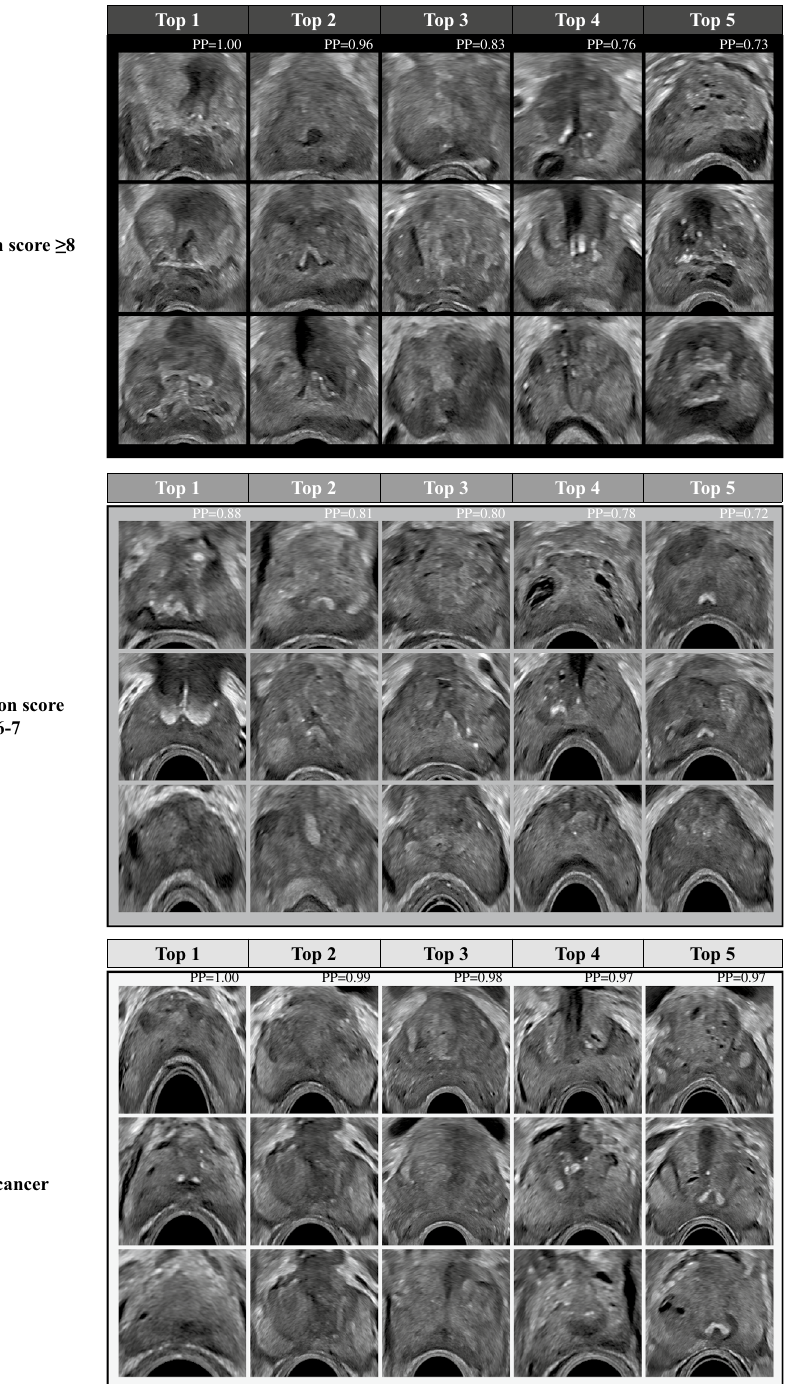
Figure 4. Prostate ultrasound images of top 5 cases corresponding to pathological cancer grading. Upper images: high-grade cancer cases. Middle images: low-grade cancer cases. Lower images: non-cancer cases. PP: normalized predicted